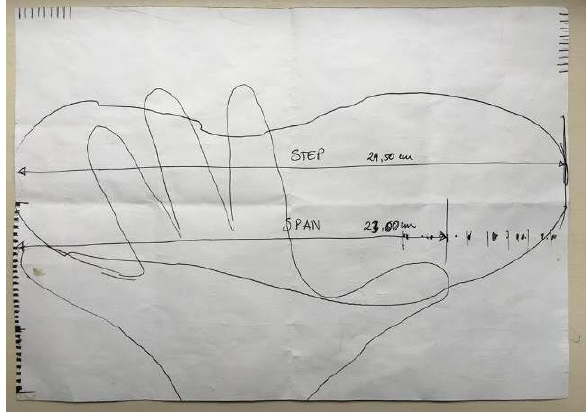
Figure 8. Understanding of basic human measures, provided by student Rui Carvalho